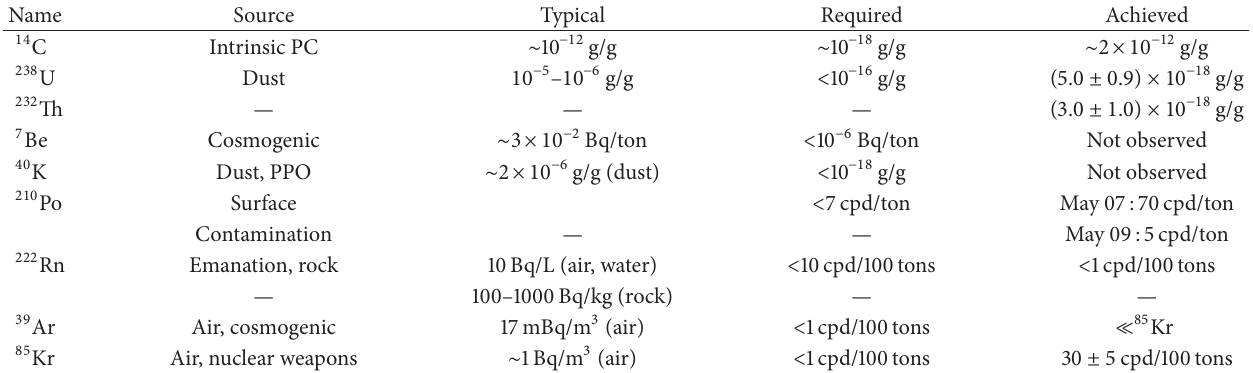
Table 1: Radiopurity of the Borexino detector during phase 1 of the